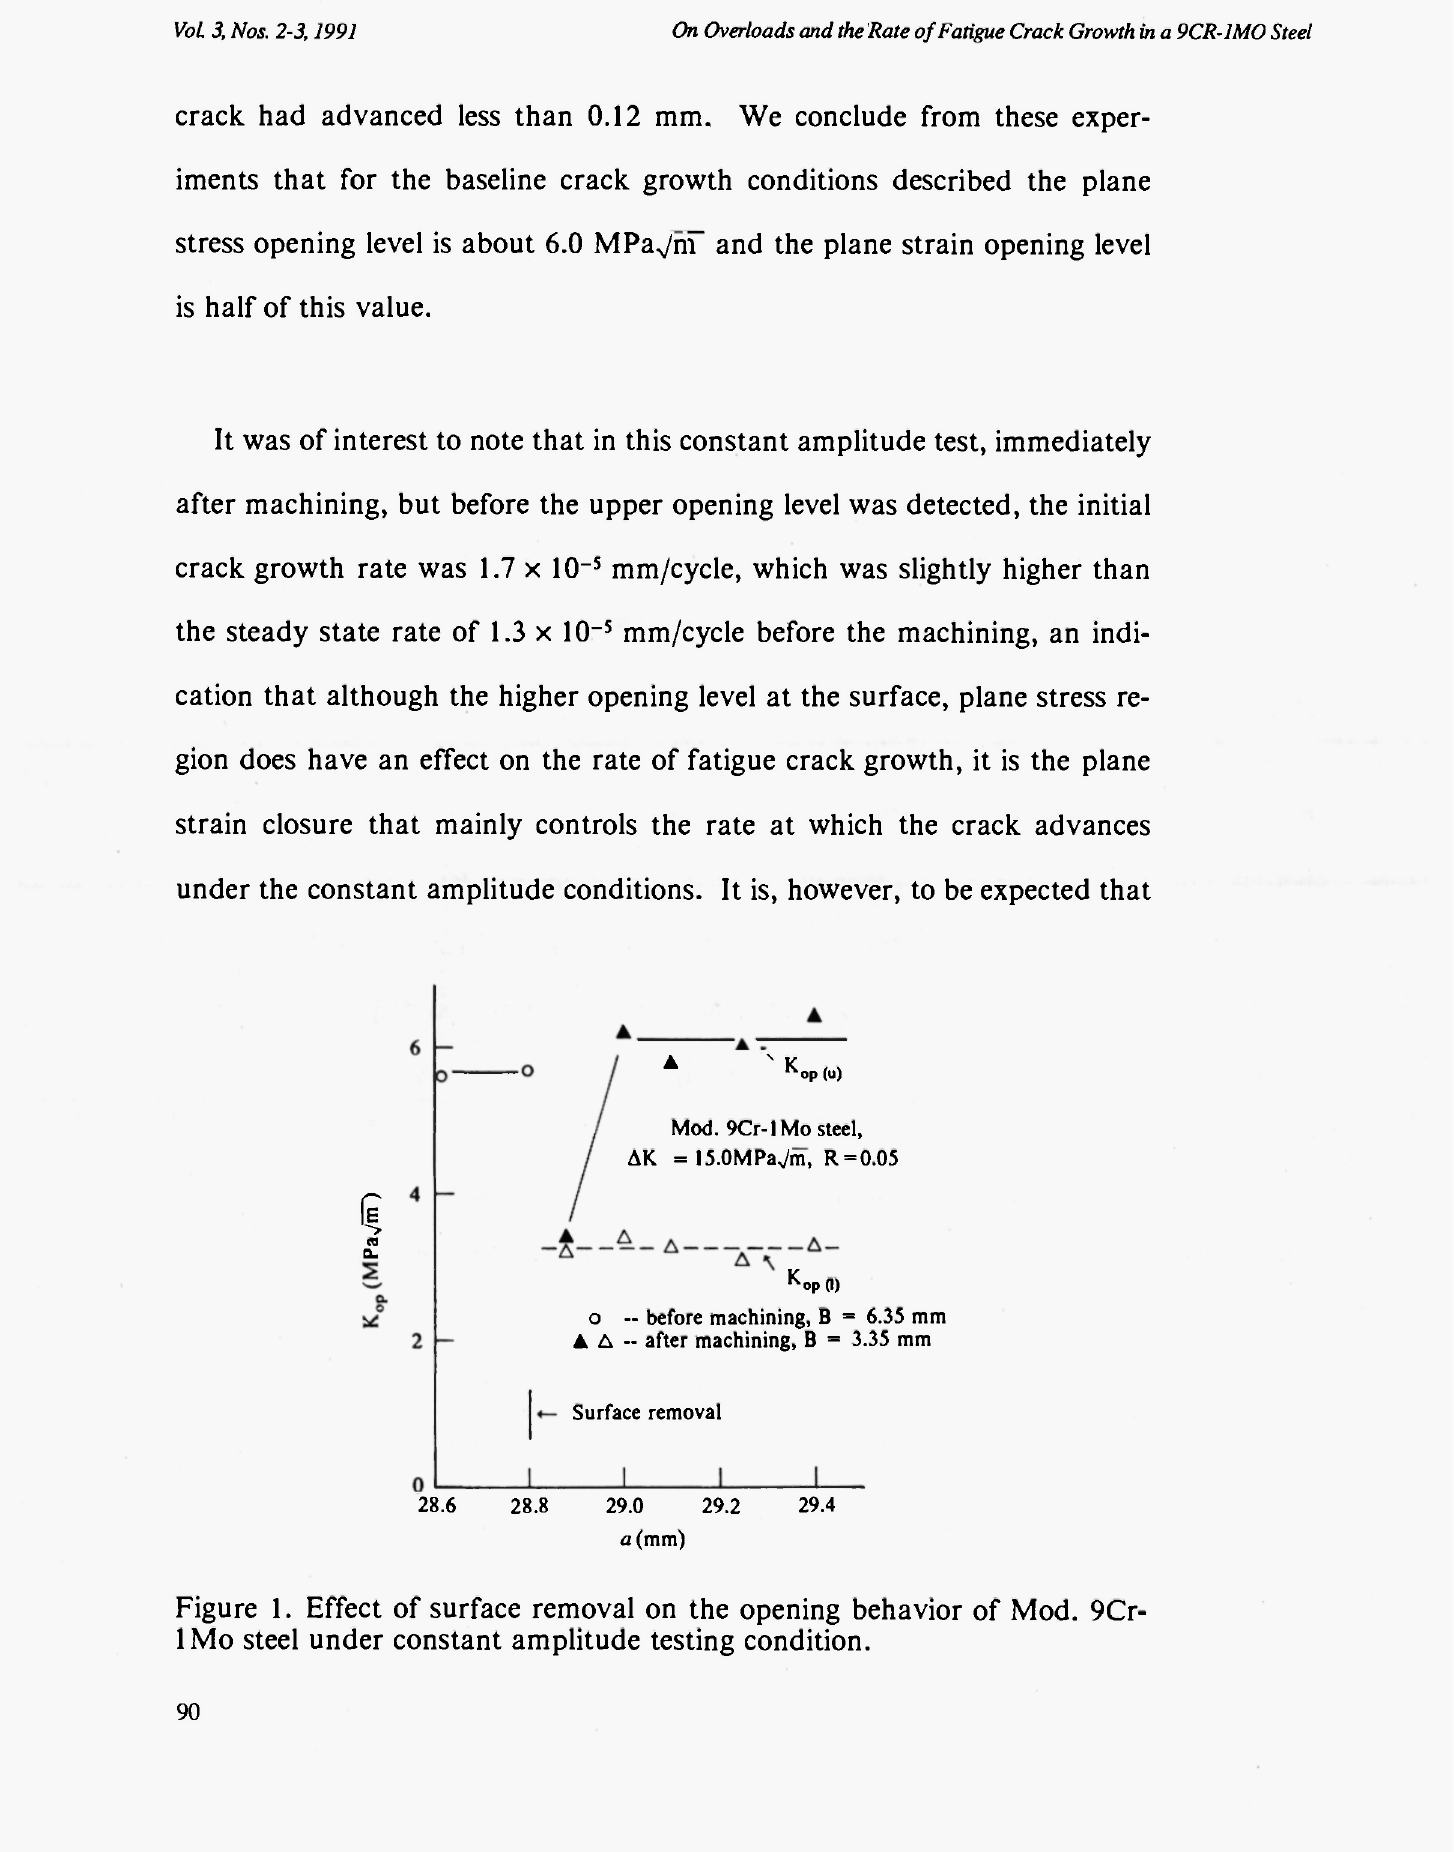
Figure 1. Effect of surface removal on the opening behavior of Mod. 9Cr- 1 Mo steel under constant amplitude testing